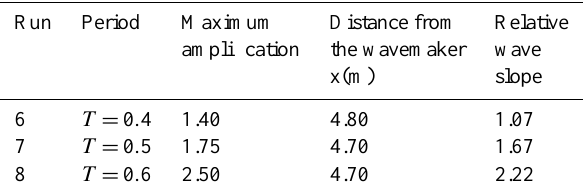
Table 2. Maximum amplification factor and wave slope along the Table 2: Maximum of the amplification factor and wave slope along the x-axis